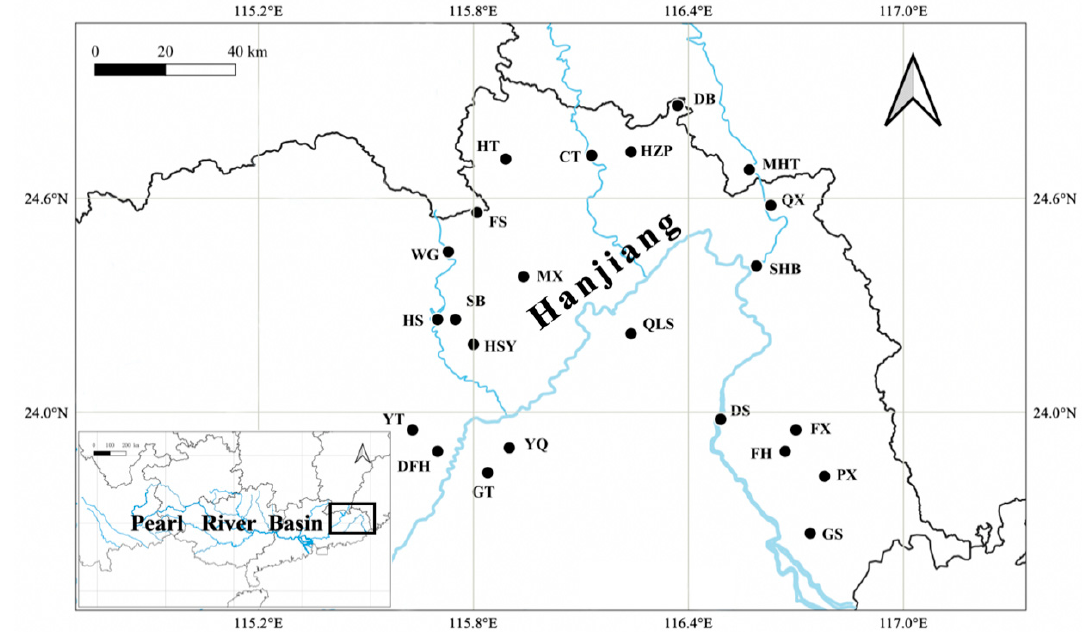
Figure 1. Localities of 23 investigated reservoirs in the Hanjiang River Basin, South China (Abbreviations of reservoir names are listed in Table S2.